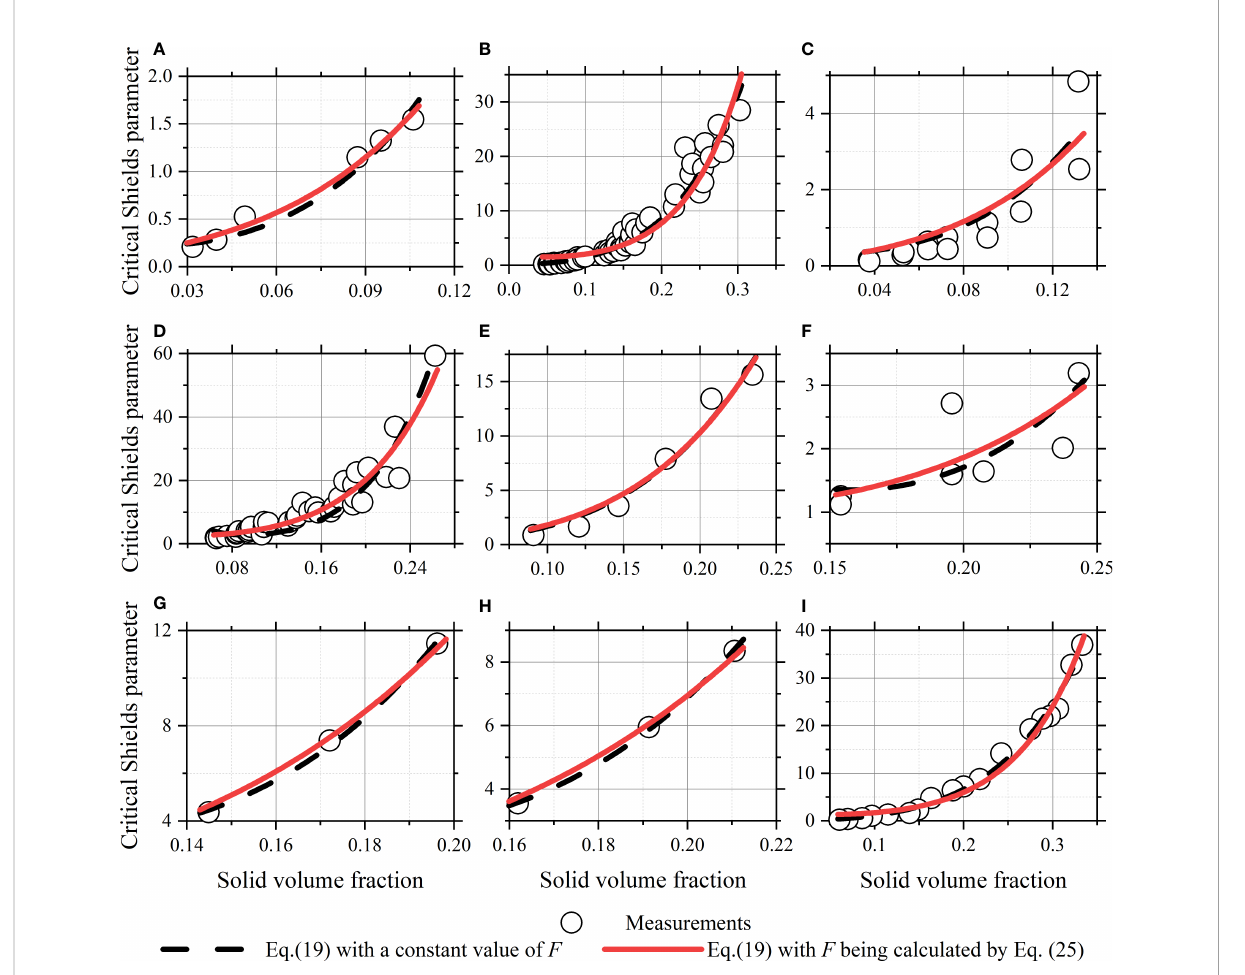
FIGURE 4 Applications of the developed formula in coastal mud. (A) Chikugo Estuary mud; (B) Tianjin New Port mud; (C) Tianjin New Port Waterway mud; (D) Lianyungang Port mud (L1); (E) Lianyungang Port mud (L2); (F) Hangzhou Bay mud; (G) Zhejiang coastal mud (L1); (H) Zhejiang coastal mud (L2); (I) Huangmaohai Estuary